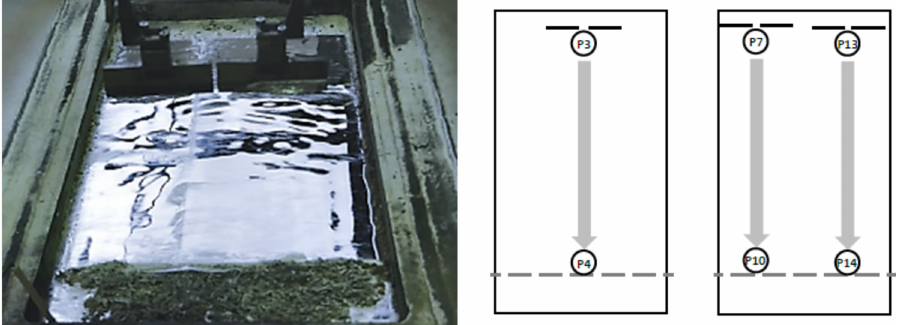
Figure 5. General efficiency of the mechanical skimming system applying linear three-step movement with a skimming rate of 0.05 m/s.